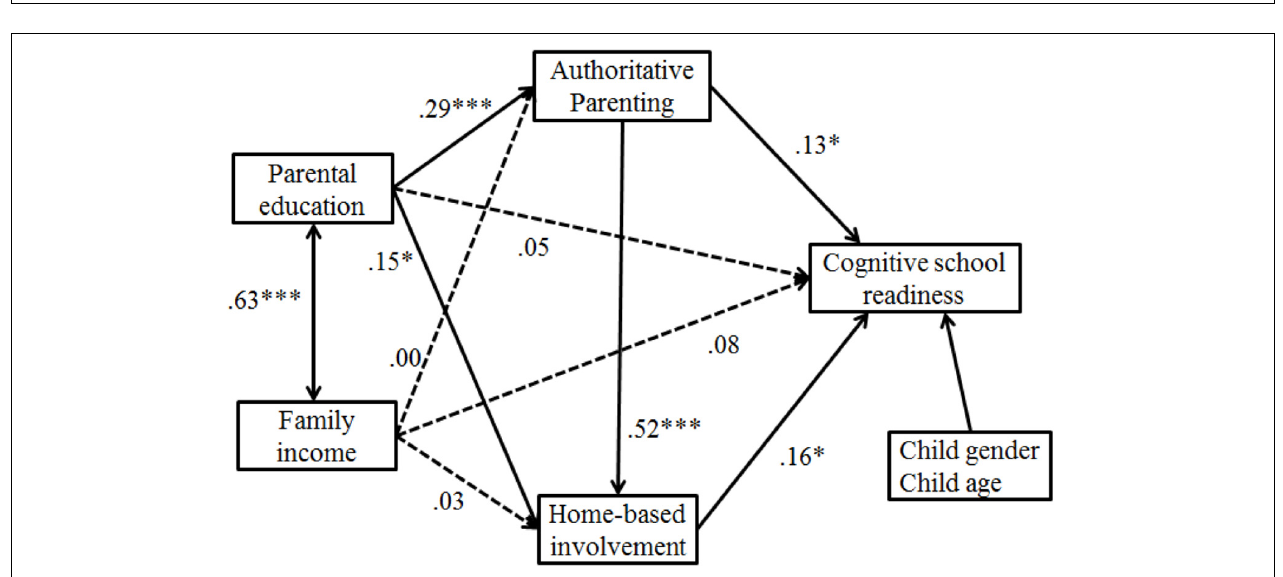
FIGURE 3 | The sequential mediation model. n = 307. Dotted lines were used for insignificant paths. ∗ p < 0.05, ∗∗∗ p <